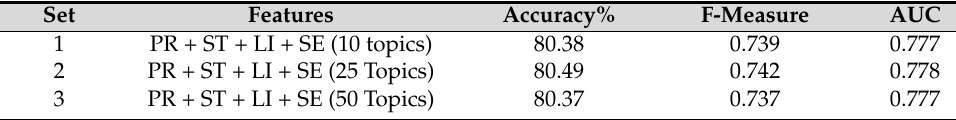
Table 7. The classification Pprformance of Random Forest.